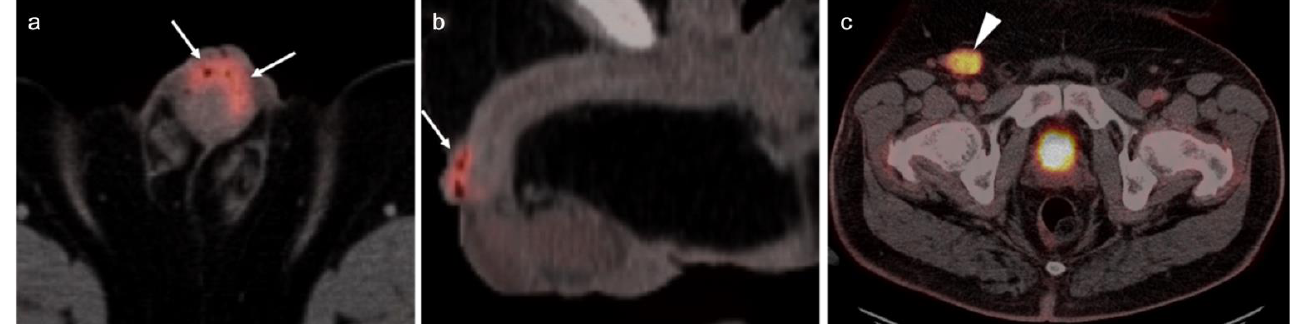
Figure 52. Squamous cell carcinoma of the prepuce of the penis on FDG PET-CT. Axial ( a ) and sagittal ( b ) FDG PET-CT images of the penis demonstrate intensely hypermetabolic tissue at the dorsal penile prepuce (white arrows). ( c ) Axial FDG PET-CT of the pelvis shows involvement of an enlarged hypermetabolic right inguinal lymph node (white arrowhead).